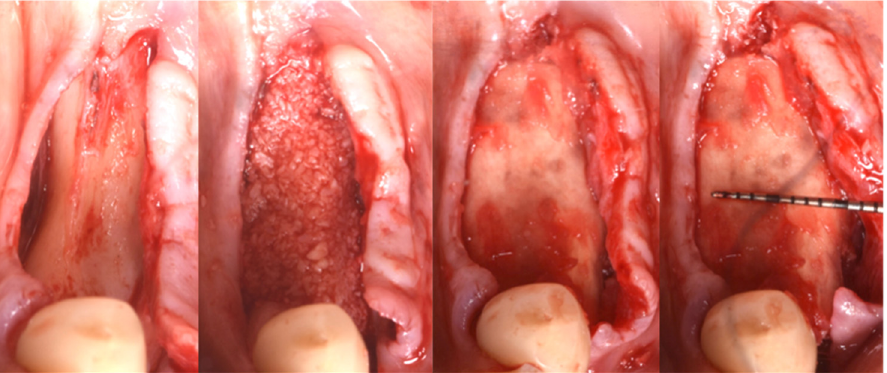
Figure 6. Guided Bone Regeneration. Flex Cortical Sheet (FCS) was positioned to cover the bone grafts.